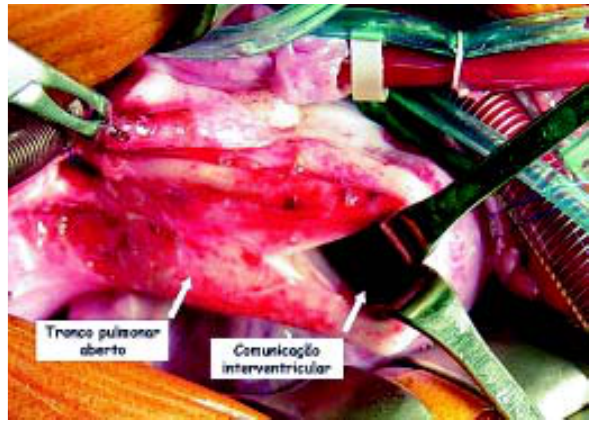
Fig. 3 – Visibilização da comunicação interventricular através da incisão longitudinal no tronco